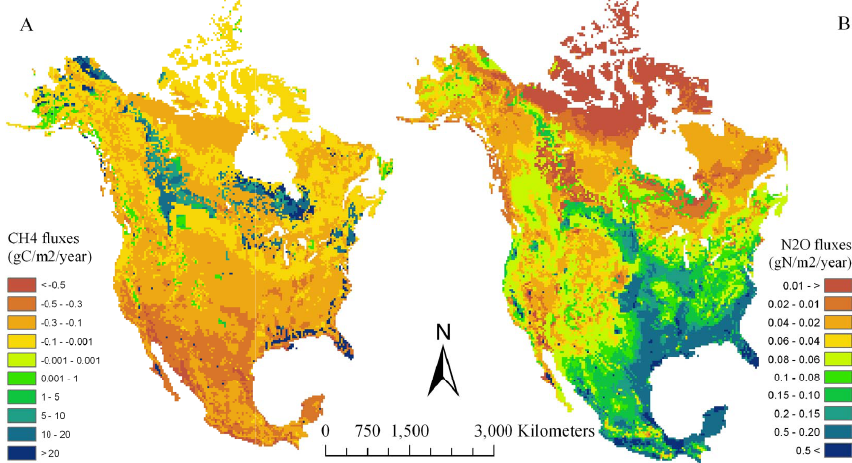
* Indicates portions of model-driven forces from regional dataset; ** indicates site outside of the continental North America.